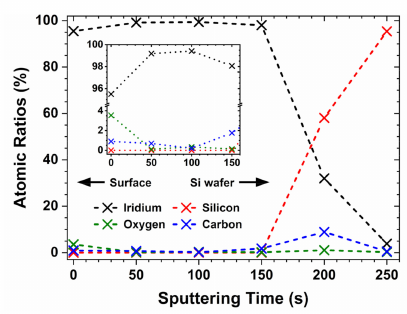
Figure 10. Atomic ratios depth profile of an Ir coating on a Si wafer using Auger electron spectroscopy (AES). The elemental composition of the layer consists of iridium, oxygen, and carbon, as well as silicon from the substrate. Less than 1% impurities (O + C) are contained in the Ir